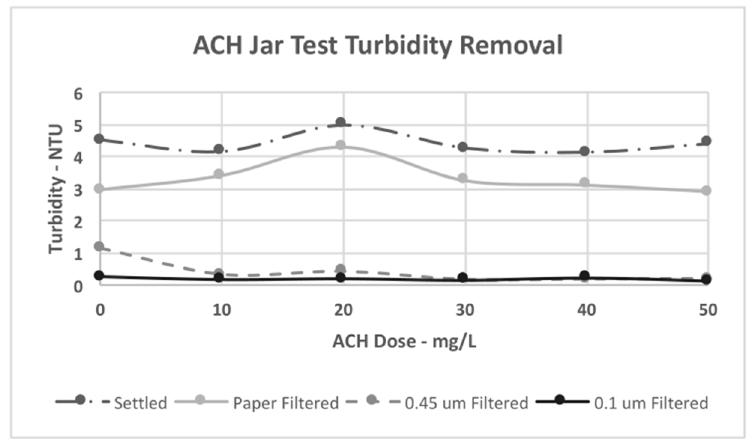
Figure 2. Turbidity after settling versus ACH dose and filtering through 8 µ m filter paper, a 0.45 µ m membrane filter, and a 0.1 µ m membrane filter.